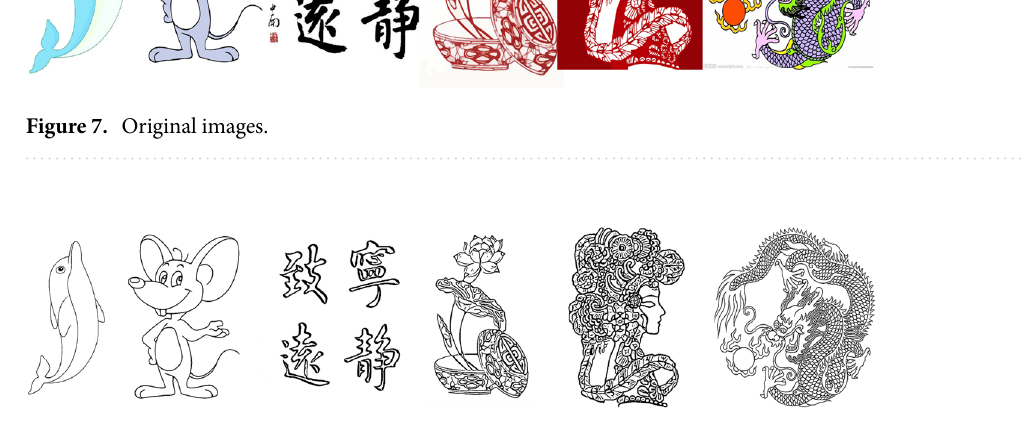
Figure 8. Images of contour extraction results.